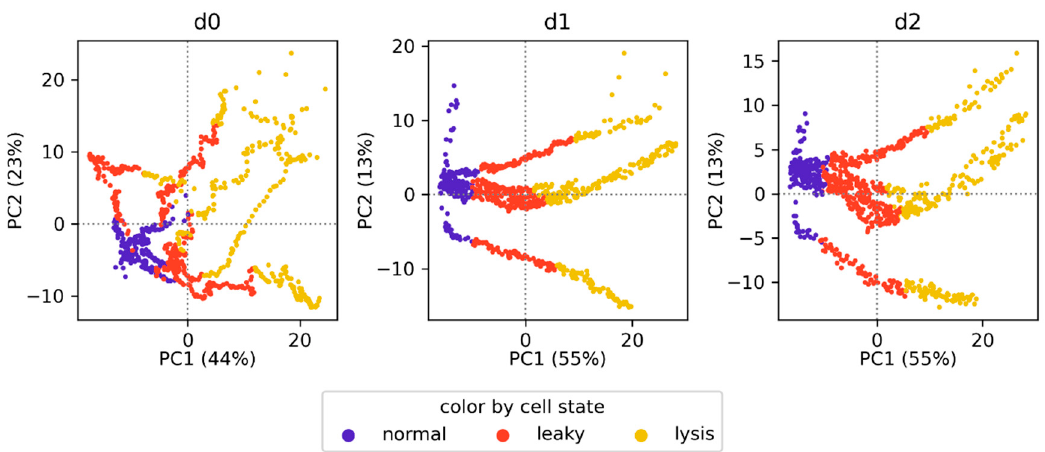
Figure 5. Baseline-corrected post-induction spectra color-coded by cell state. Parentheses show the percentage of variance explained by the respective principal component. The columns show zero-order (d0), first-order (d1), and second-order (d2) derivatives.